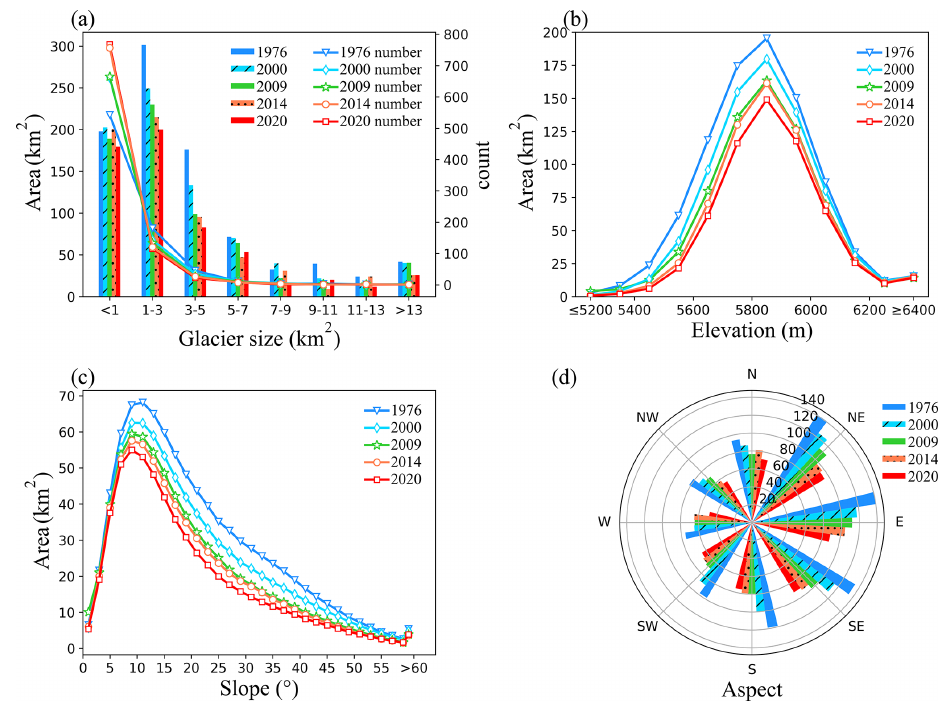
Figure 2. Glacier distribution in the WNR in 1976, 2000, 2009, 2014 and 2020. (a) Number and area of glaciers by size category. (b) Distri- bution of glacier area with altitude. (c) Distribution of glacier area with slope. (d) Distribution of glacier area with aspect. Data in 2009 came from the Chinese Glacier Inventory